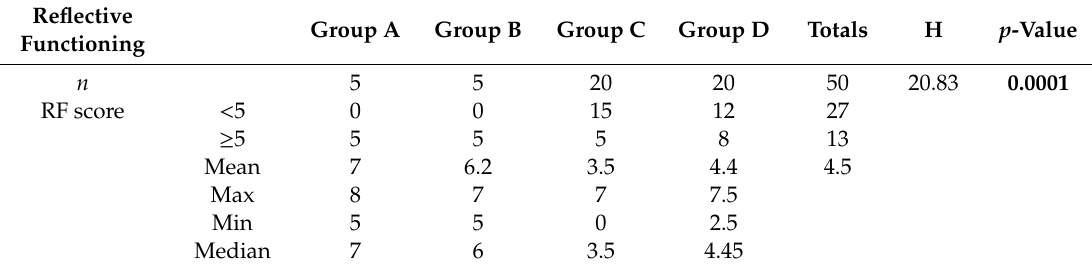
Table 2. Reflective